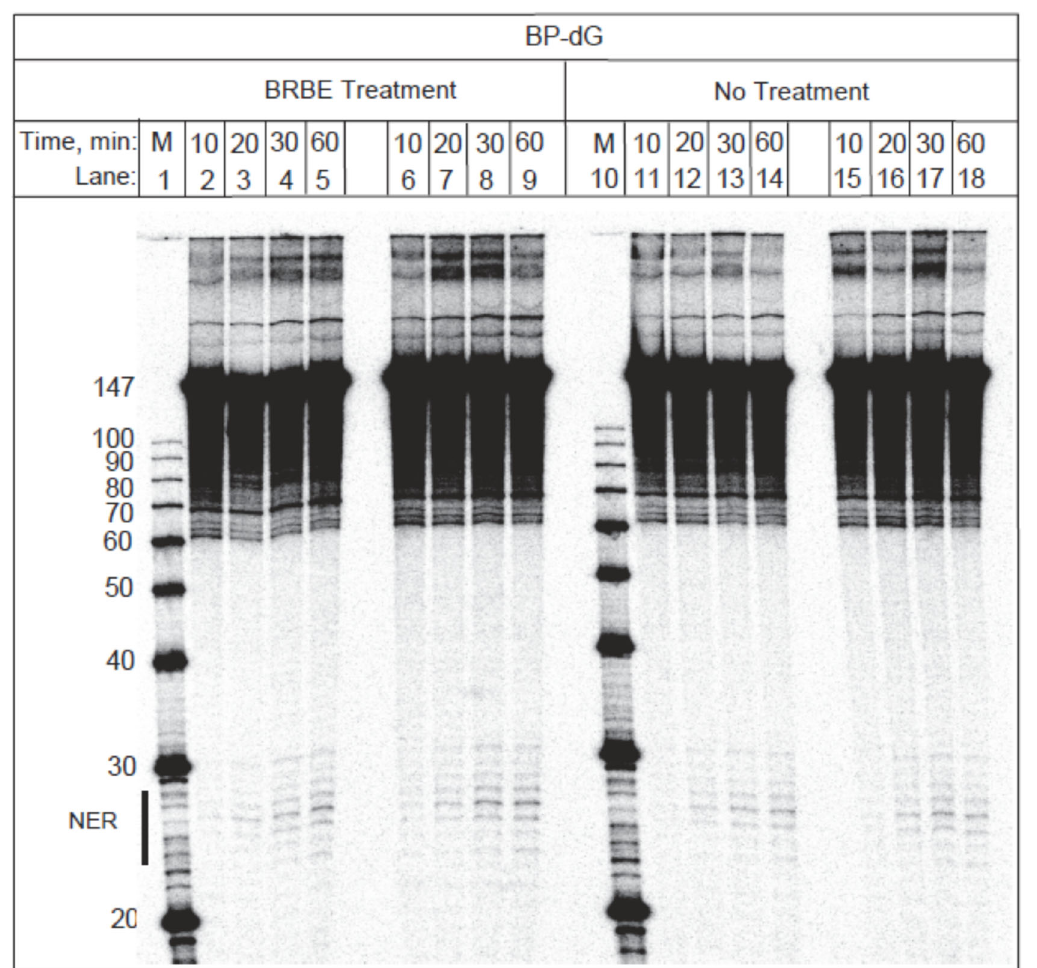
Figure 4. BP-dG adduct substrates . Gel electrophoresis image. Time dependence of formation of NER products of 147-mer DNA. Duplexes containing single benzo[a]pyrene diol epoxide-derived guanine adducts (BP-dG). After incubation in extracts from intact HeLa cells untreated or pre-treated with BRBE. The positions of the NER excision products are denoted by a vertical bar on the bottom left side of the gel. As expected, identical, but unmodified oligonucleotide sequences remain un-incised as demonstrated elsewhere [19,29], and which is consistent with the lXPD helicase-driven lesion verification mechanism of NER [30] that ensures that unmodified DNA sequences are not processed by the NER apparatus (see below).